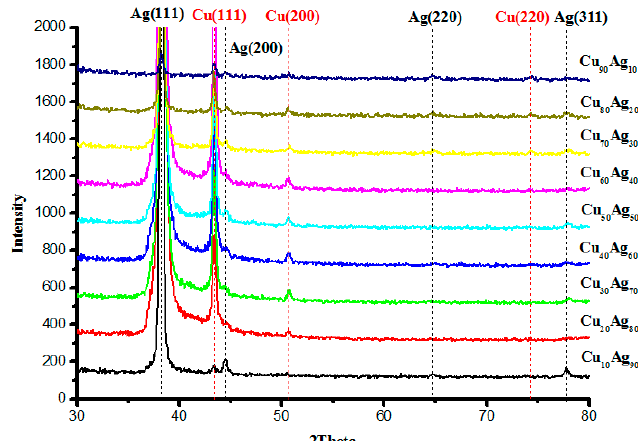
Figure 3. XRD patterns of annealed Cu–Ag films as a function Cu:Ag atomic ratios. (Annealing conditions: 400 °C for four minutes).